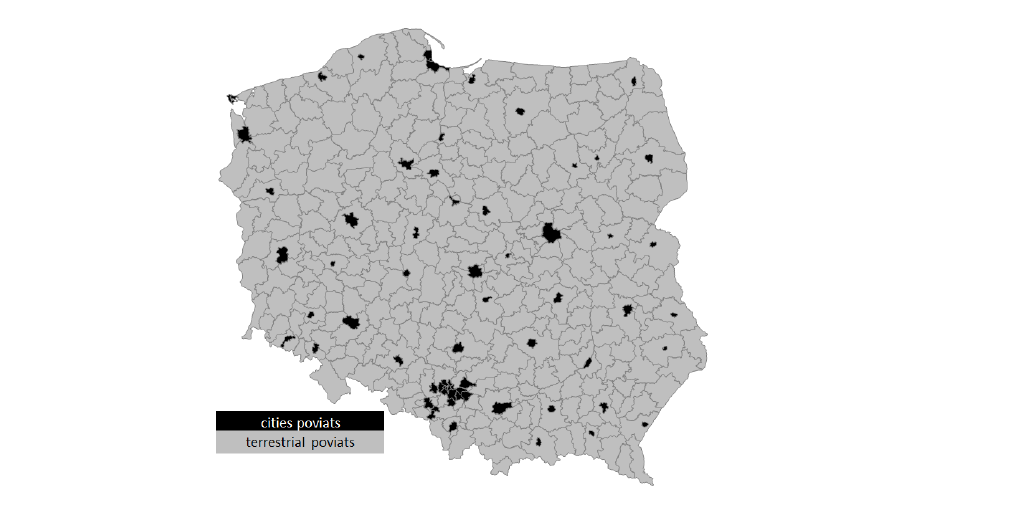
Figure 1. Research area—districts in Poland. Source: own study. Districts in Poland—380 (total); terrestrial districts—314; cities poviats—66.